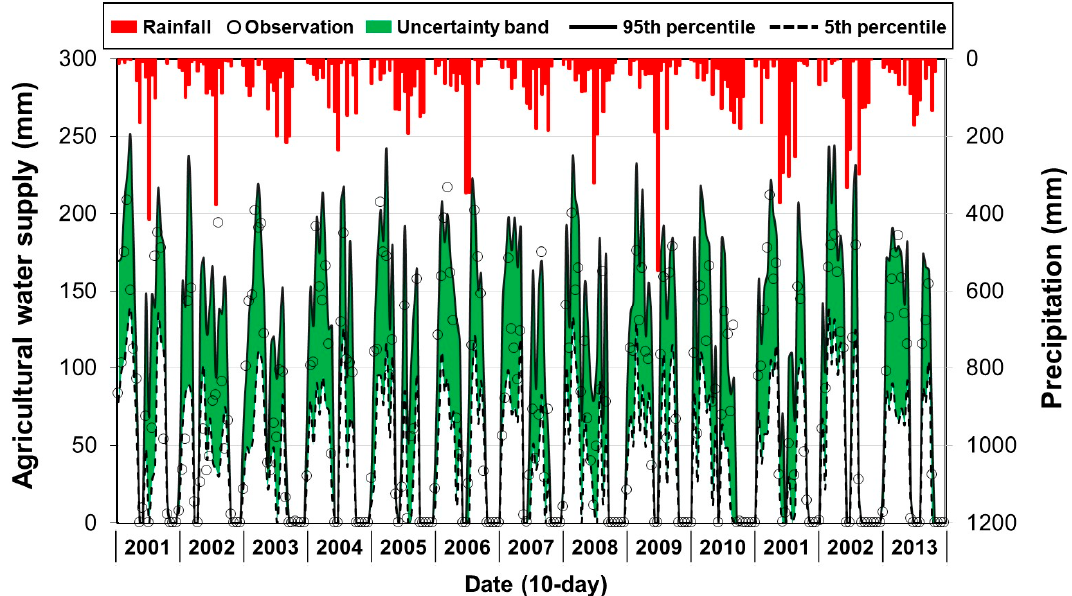
Figure 4. Uncertainty band (90% confidence interval, or 90CI) for the simulated agricultural water supply (AWS) due to parameter uncertainty, calculated using generalized likelihood uncertainty estimation (GLUE), at 10-day intervals.